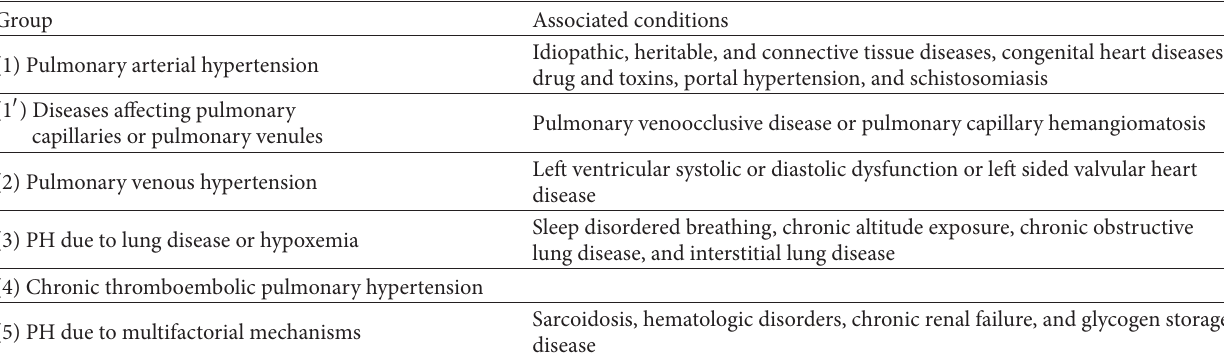
Table 1: Current clinical classification of pulmonary